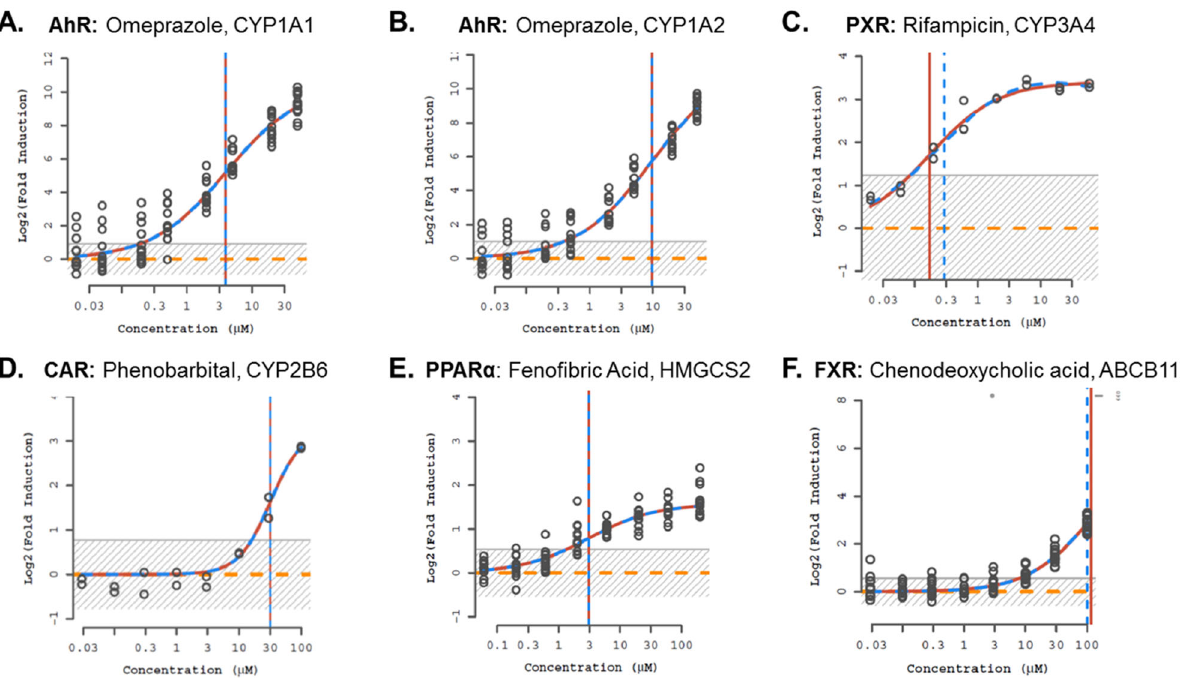
Fig. 1 Dose-response curves for reference chemicals and transcriptionally regulated genes. Log2 (Fold Induction) response pro fi les of ( A ) CYP1A1, ( B ) CYP1A2 upon exposure to AhR positive control, omeprazole; ( C ) CYP3A4 with rifampicin treatment; ( D ) CYP2B6 in response to CAR-inducing, phenobarbital exposure; ( E ) HMGCS2 after treatment PPAR α positive control, feno fi bric acid and ( F ) ABCB11 expression with chenodeoxycholic acid treatment. Three dose-response relationships are indicated in each plot, the fi rst (no response) is a horizontal long- dashed line, while the Hill function (short-dashed line) and gain-loss (solid line) response models change with the points. The vertical lines indicate the estimate 50% activation concentration (AC50) for the two response models. The gray shaded region indicates estimated background.